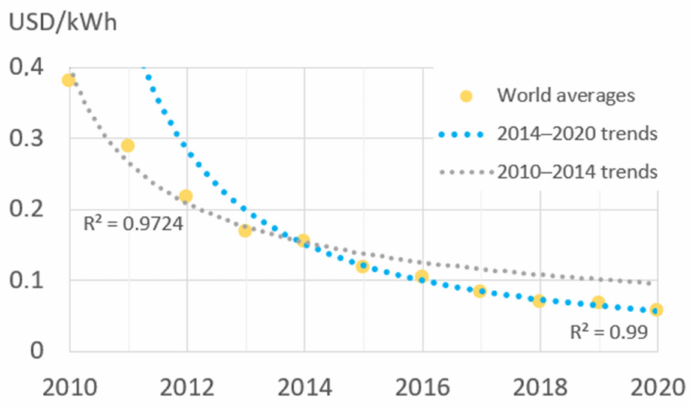
Figure 6. Dynamics of PV electricity generation cost in the